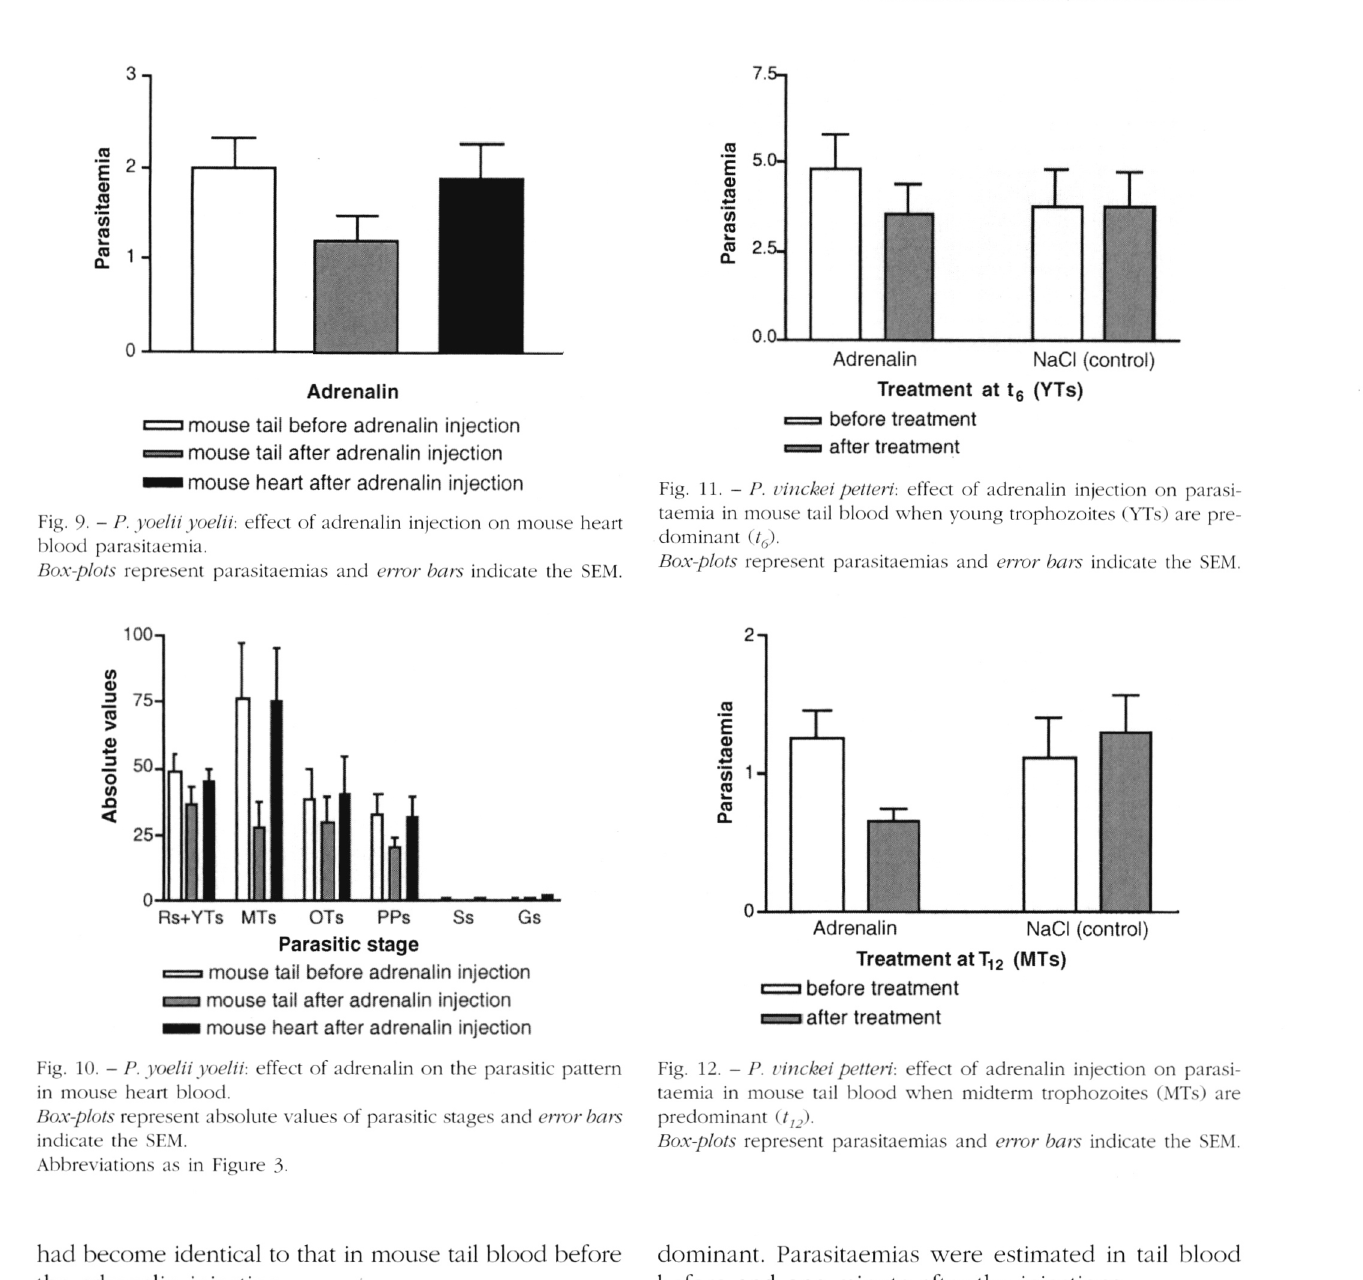
Fig. 10. - P. yoelii yoelii: effect of adrenalin on the parasitic pattern in mouse heart blood. Box-plots represent absolute values of parasitic stages and error bars indicate the SEM.